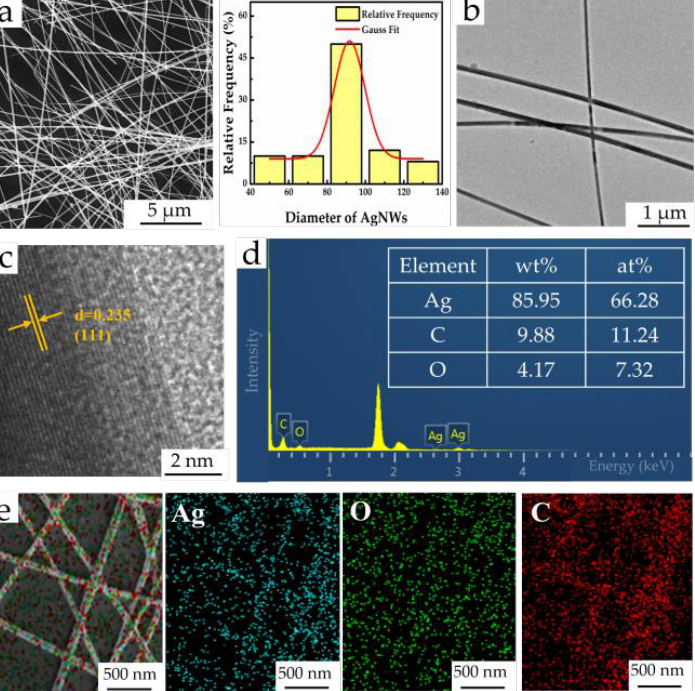
Figure 1. ( a ) SEM image and Gaussian statistical distribution of diameter; ( b ) TEM image; ( c ) HRTEM image; ( d ) EDS composition chart; ( e ) element distribution maps of AgNWs.